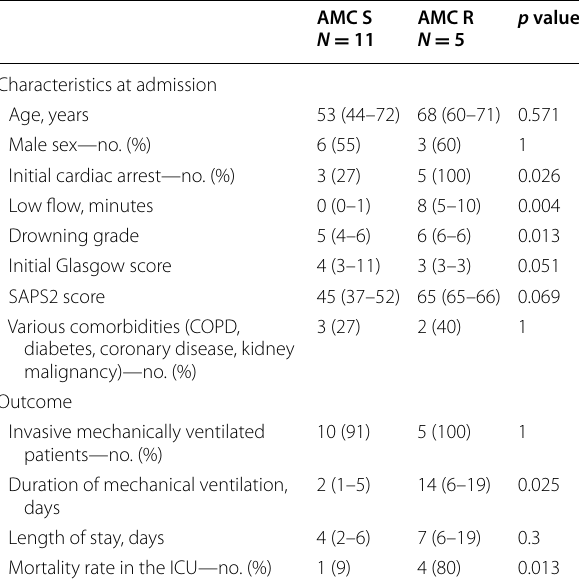
Table 5 Clinical characteristics and outcomes of patients with positives respiratory samples according to the sen- sitivity to amoxicillin-clavulanate of the microorganisms